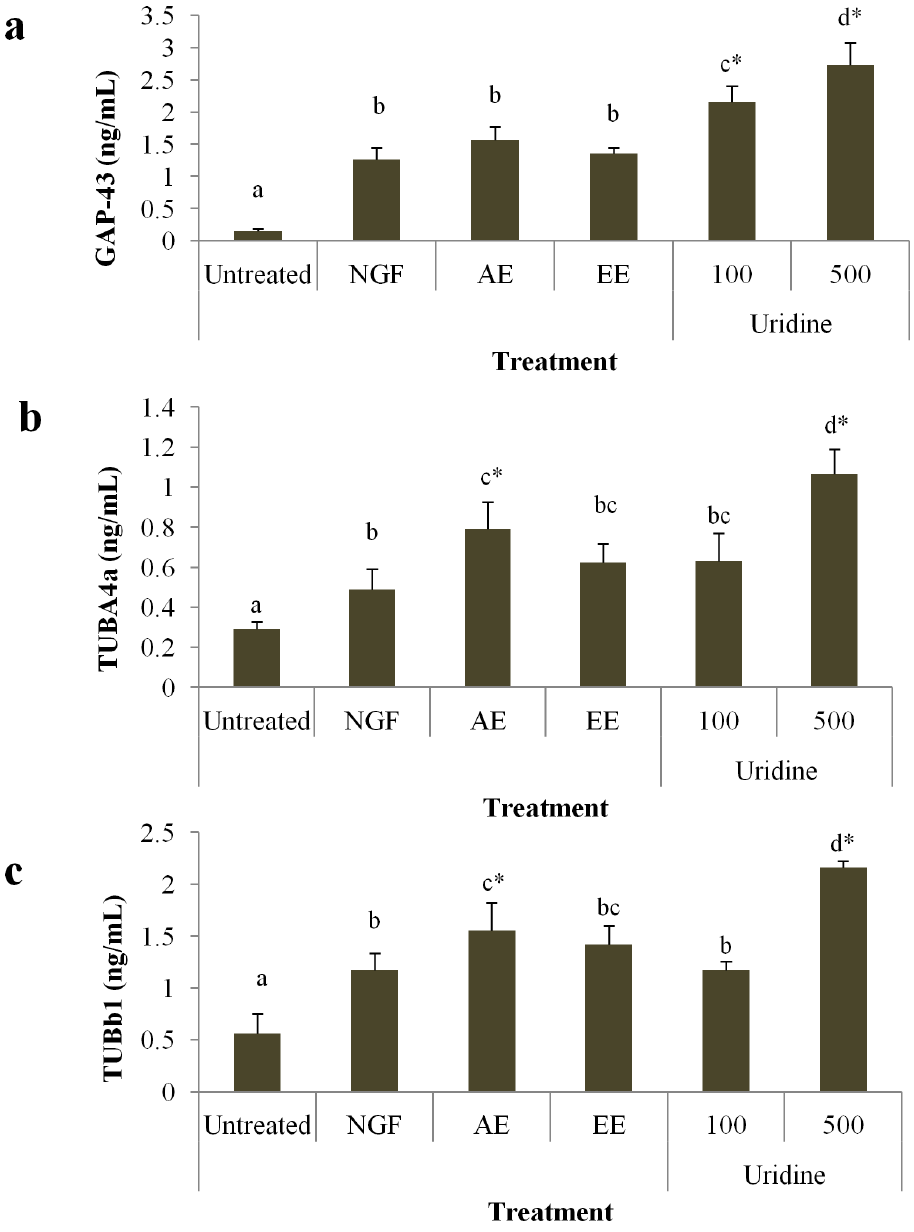
Fig 7. Uridine and mushroom extracts increased the activity of GAP-43 (a), Tubulin alpha 4a (b), and tubulin beta b1 (c) in N2a cells. Data are expressed as mean ± S.D. for n = 3. Different alphabets represent significant differences between samples ( p < 0.05). * p < 0.05 significantly higher relative to